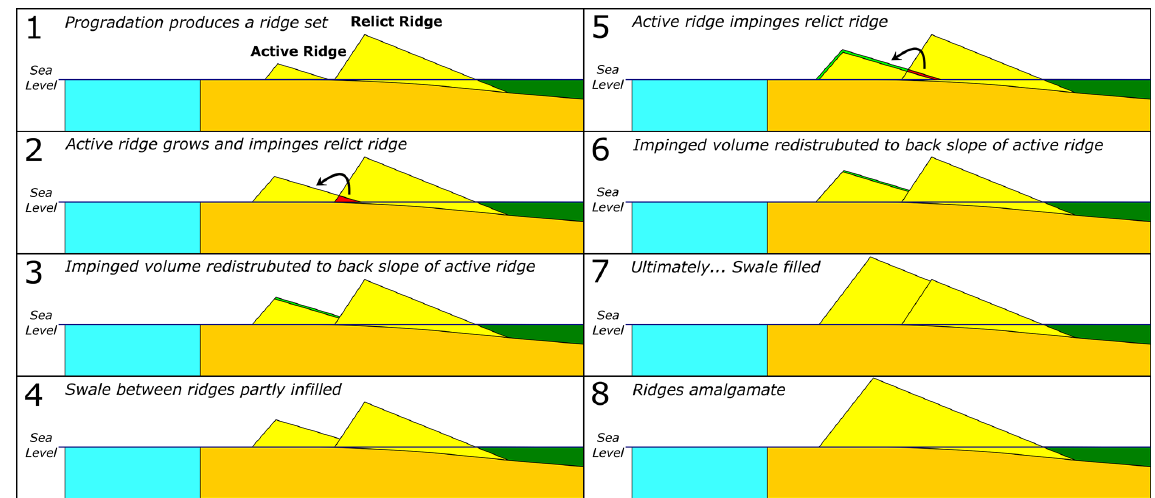
Figure 4. Conceptualization of swale-infilling and cross-shore foredune ridge amalgamation in the Subaerial Barrier Sediment Partition- ing (SBSP) model. As an active ridge grows and impinges a landward or relict ridge, the inflating ridge volume is redistributed to fill the swale between ridges. When swale filling is complete, the active and relict ridges amalgamate into a single active ridge. Yellow represents barrier sand, blue represents ocean, and dark green represents marsh. Note that the backbarrier slope of the sandy platform is shown for illustrative purposes and is not currently parameterized in the